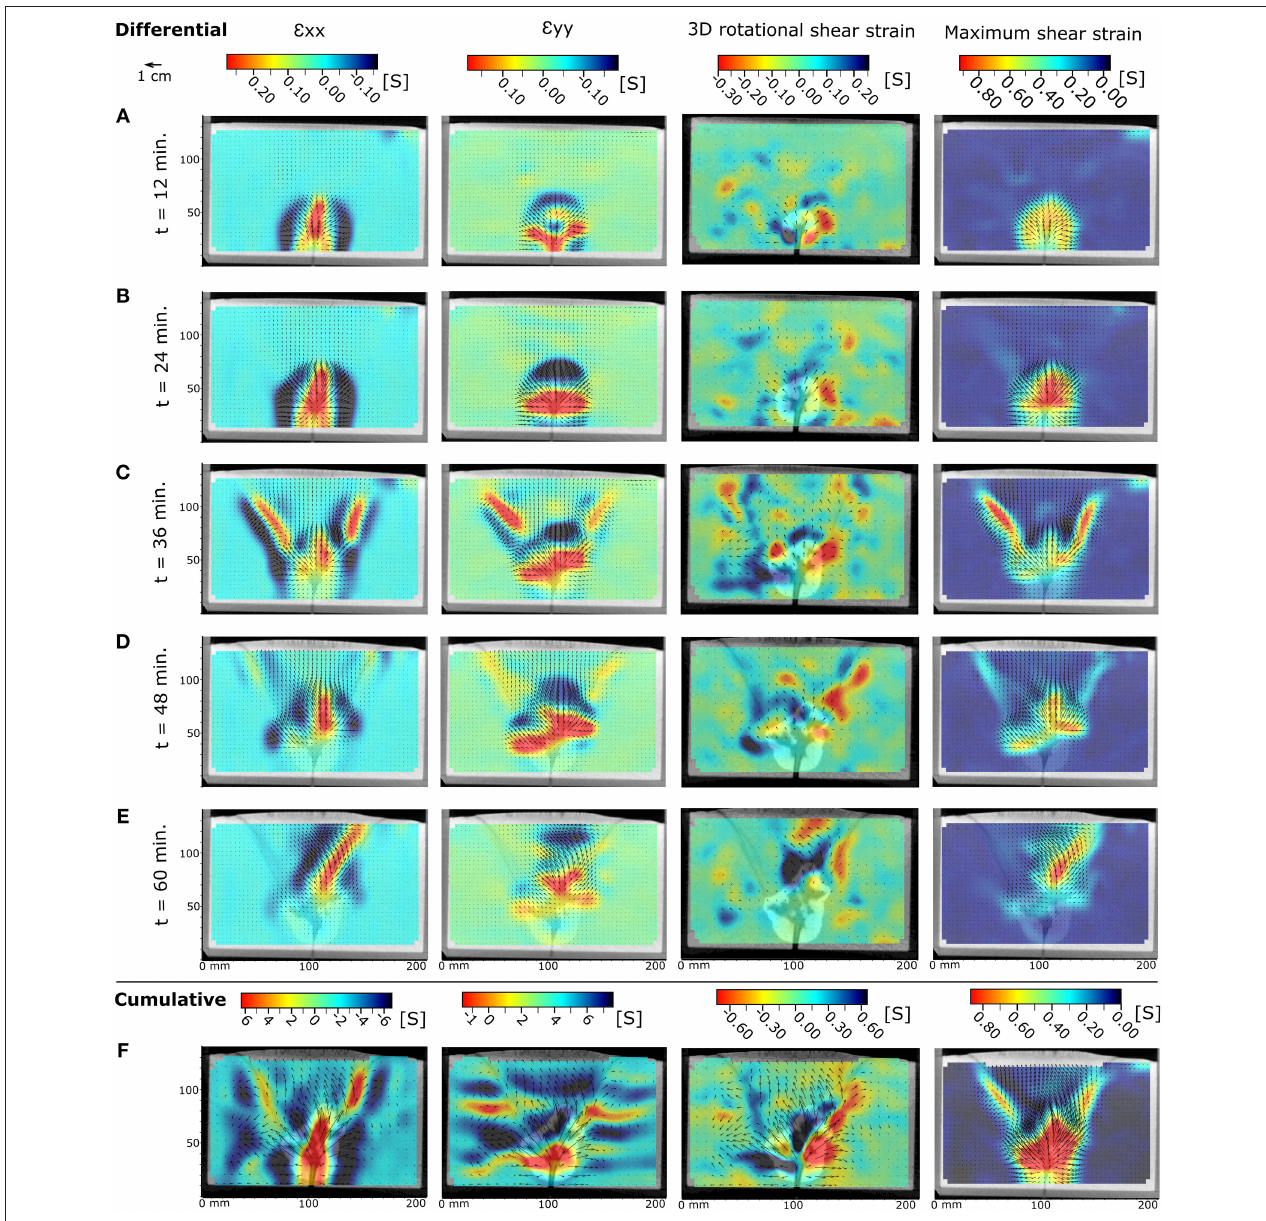
FIGURE 9 | DVC results for differential (A–E) and cumulative (F) host material deformation induced by a cryptodome intrusion in a 90:10 wt% sand:plaster mixture (SPCTIN02 in Table 2 )—arrows indicate magnitude and orientation of calculated displacement vectors: (Left column) Horizontal (longitudinal) strain, shortening is negative/blue; (Central left column) Vertical (axial) strain, shortening is negative/blue; (Central right column) Horizontal rotational shear strain around the z-axis, anticlockwise rotation is positive/blue; (Right column) Maximum shear strain.